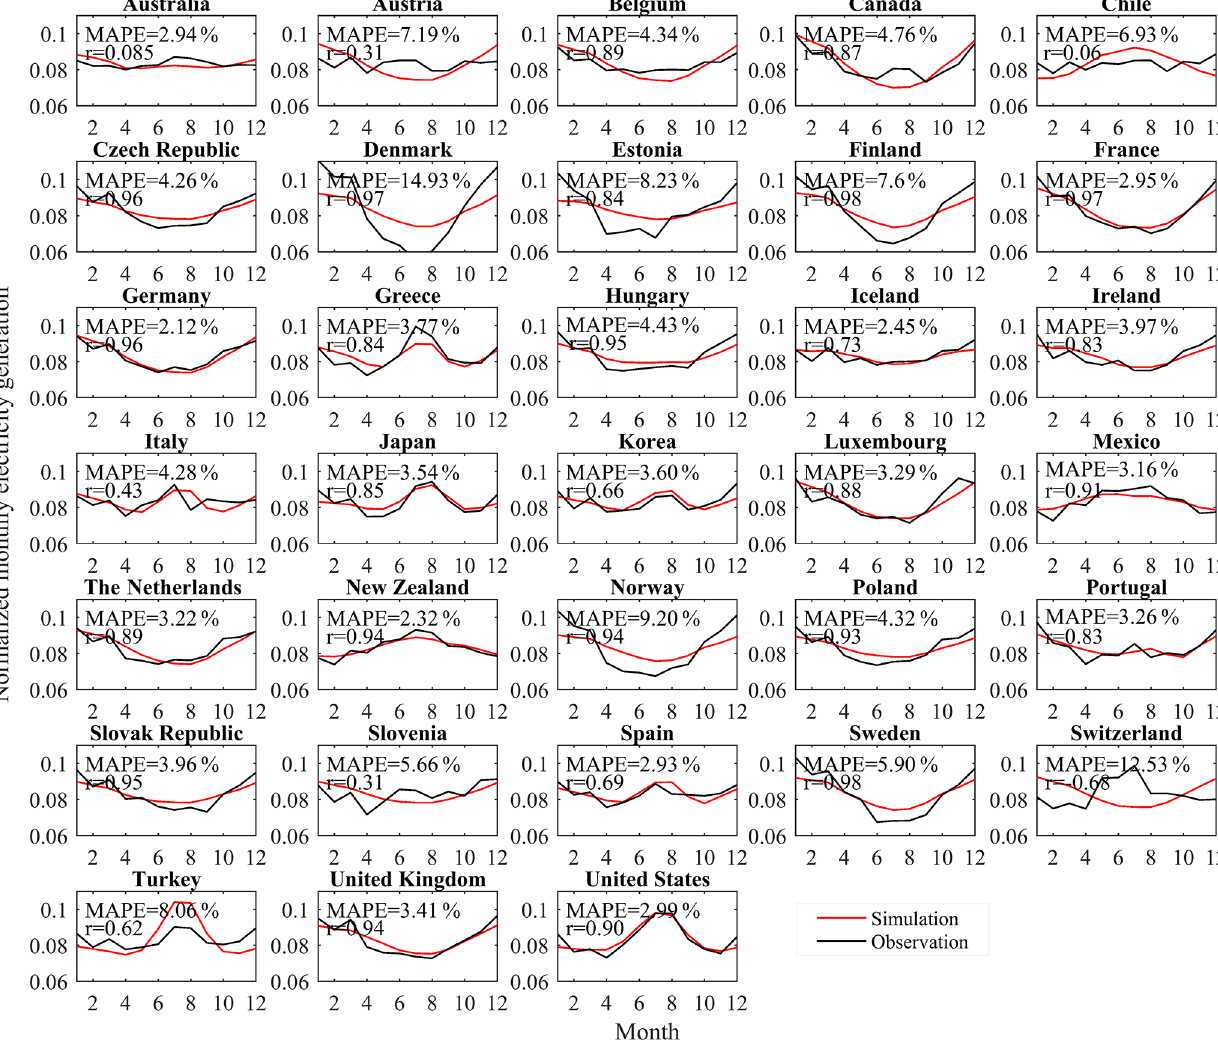
Figure 2. Comparison between simulation and observation of normalized monthly mean electricity generation in 33 OECD countries dur- ing 2000–2012: the normalized monthly electricity generation is the proportion of monthly electricity generation to the total annual electricity